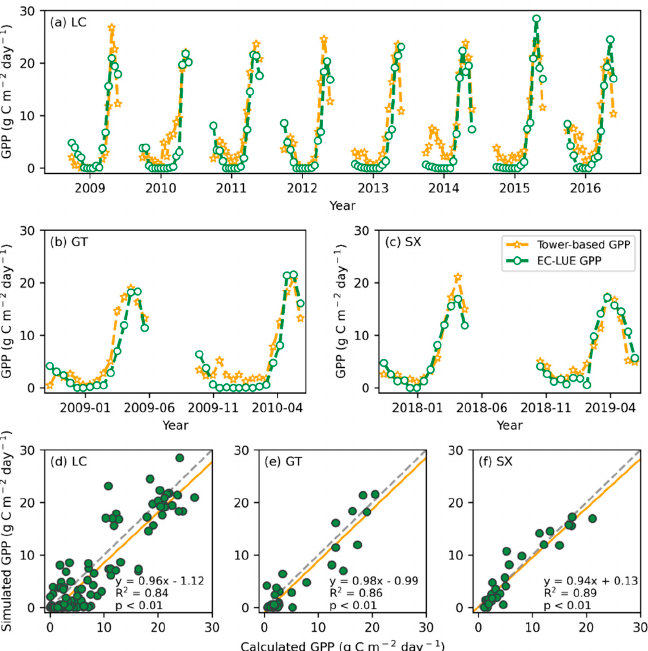
Figure 2. Calculated GPP based on EC measurements and simulated GPP based on EC-LUE model. ( a – c ) show the temporal variations of GPP at the Luancheng (LC), Guantao (GT) and Shouxian (SX) sites, respectively; ( d – f ) show the correlation between calculated and simulated GPP in these three EC sites; the yellow solid lines indicate the regression lines and the grey dashed lines are the 1:1 lines.